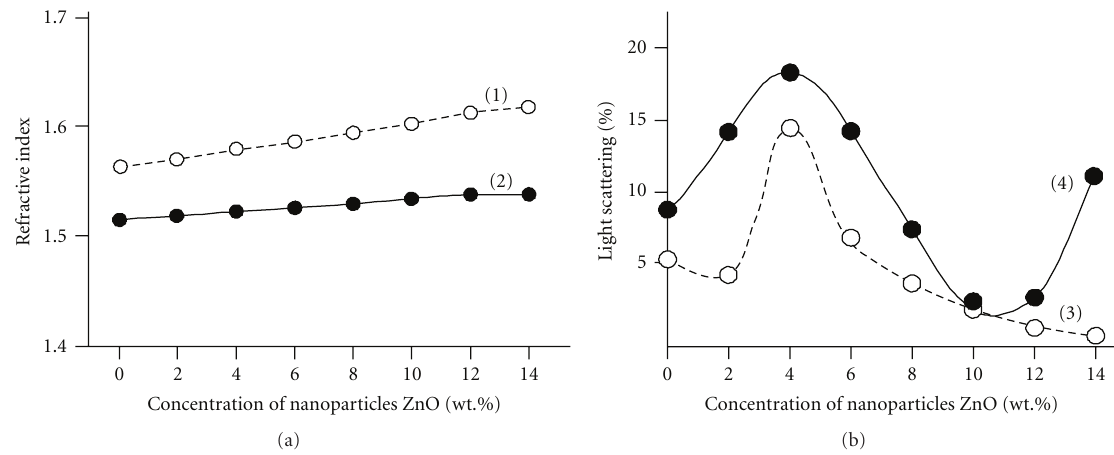
Figure 1: Refractive index (a): experimental RI (1) and calculation RI (2), light scattering (b): before (3) and after (4) water sorption of the composition BisA/2Carb (30/70) versus ZnO nanoparticles concentrations.